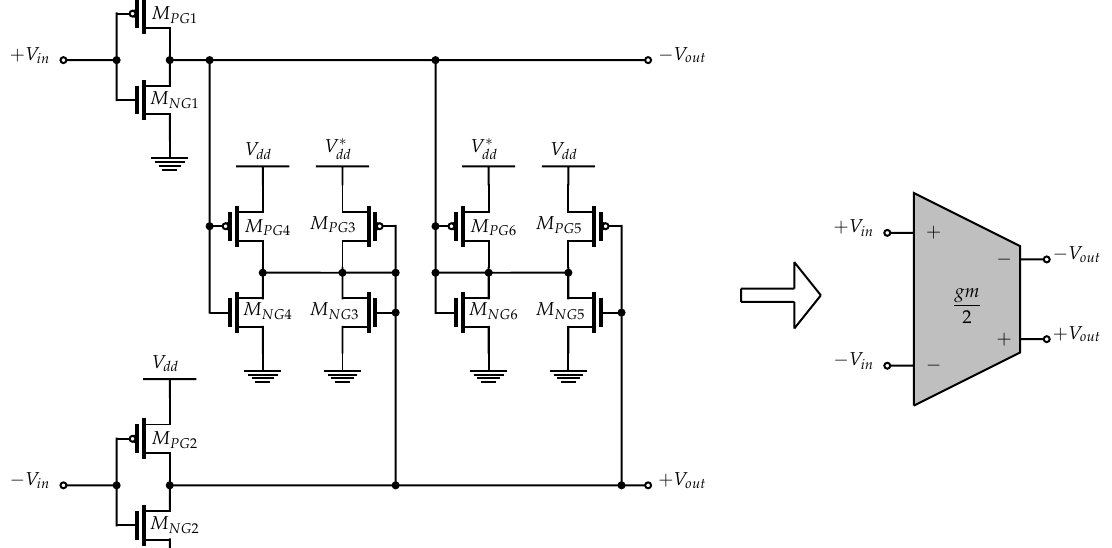
Figure 7. CMOS circuit used as transconductor.